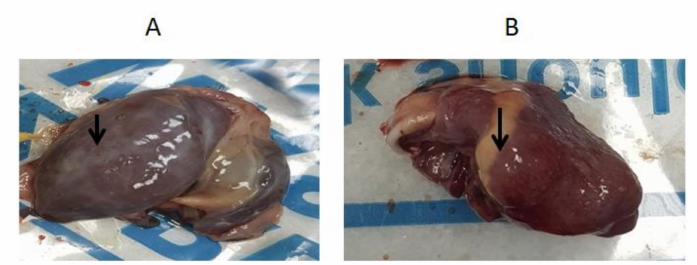
Figure 2. Observed PM (Postmortem) lesions: fibrinous perihepatitis ( A ) and hydropericardium ( B